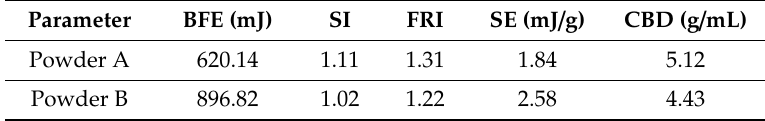
Table 5. Rheological data used for Pearson correlation calculation examining the dependency of rheological data on particle size and shape for powders A and B.